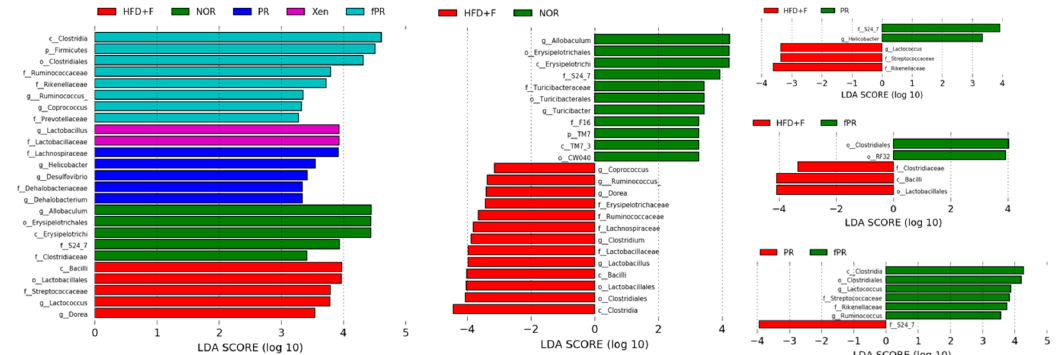
Figure 6. Linear discriminant analysis effect size (LEfSe) assessment of the bacterial communities in the mouse stool samples. The diversity of the gut microbiota was altered by feeding a HFD and fructose-supplemented water. The LEfSe plot shows enriched bacteria in all phenotypic categories. The alpha value for the factorial Kruskal–Wallis test is < 0.05, and the threshold on the logarithmic LDA score for a discriminative feature is >2.0.